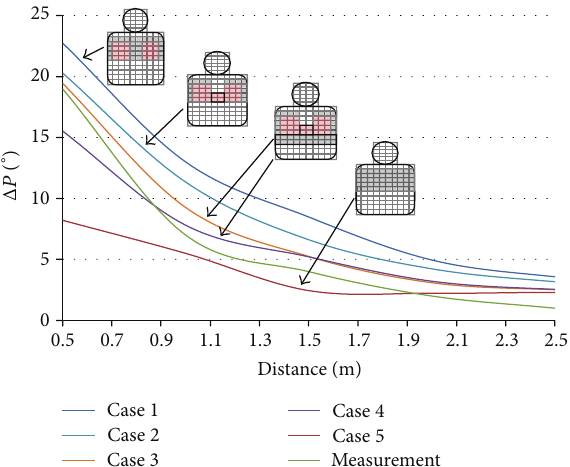
Figure 12: Phase variation (numerical model) as function of the emitted frequency and for two antenna reflection